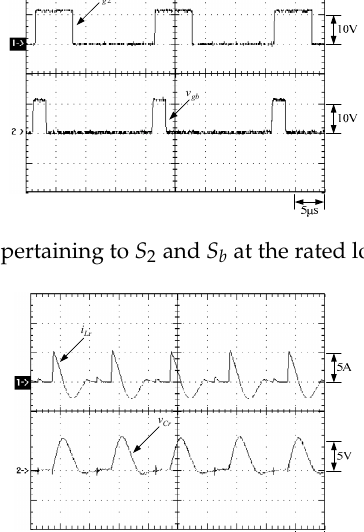
Figure 27. Waveforms pertaining to L r and C r at the rated load: (1) i Lr ; and (2) v Cr .